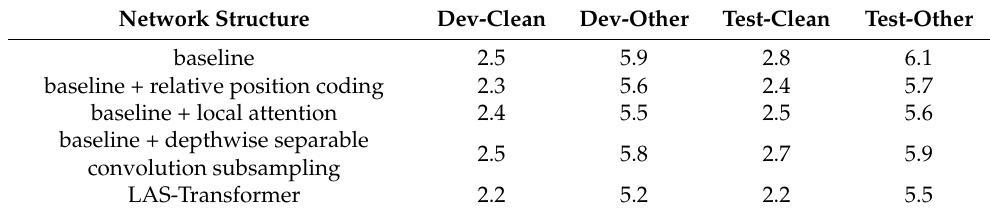
Table 2. Results of the ablation study of the proposed LAS-Transformer model.